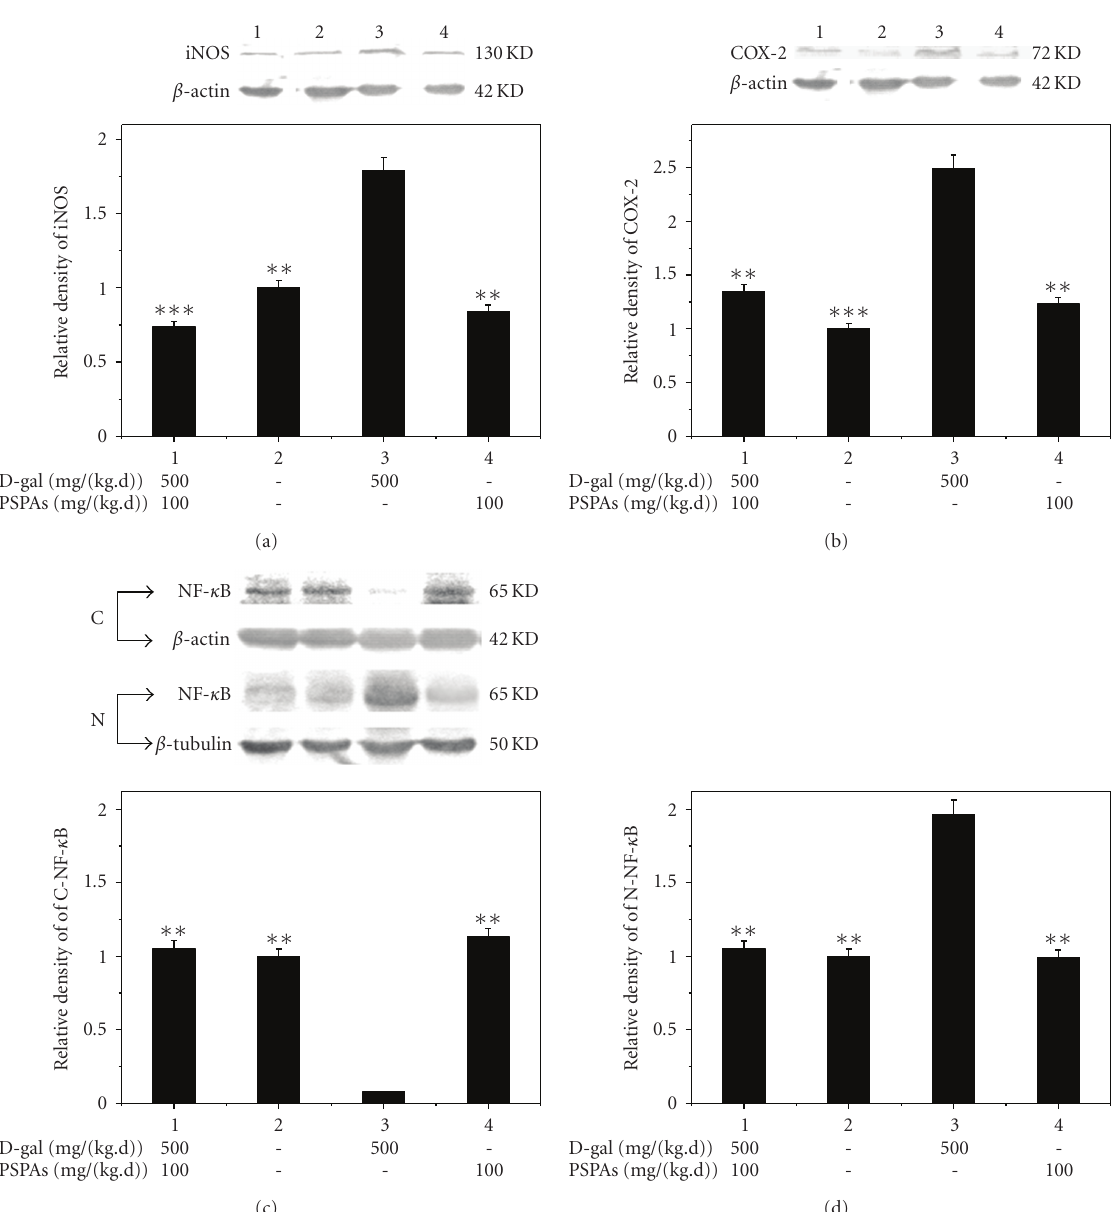
Figure 5: Western blot analysis of the expression level of representative protein in mouse brain ( n = 3). (a) iNOS, (b) COX-2, (c) NF- κ B: cytoplasmic (C) proteins were isolated and used for western blot analysis, (d) NF- κ B: Nuclear (N) proteins were isolated and used for western blot analysis. Data are averages from three independent experiments. Each value is the means ± SEM ∗ P < . 05, ∗∗ P < . 01, ∗∗∗ P < . 001 versus D-gal